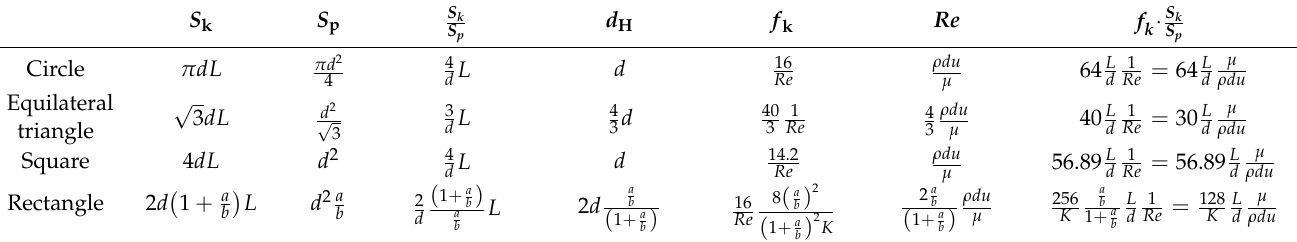
(cid:16) (cid:17) · S k · d = 128 According to Figure 4, since f k · ρ du monotonously decreases with respect L K S p µ to a , this also contributes to the monotonical decrease in ∆ p . Focusing on each of the divided b · d parameters, S k decreases monotonically in the same way, whereas f k · ρ du is found to L S p µ · S k · d have a local minimum value of ca. 11.4 when a is ca. 3.40. That is, f k · ρ du decreases L S p µ b monotonically and mitigates moderately when a takes more than ca. 3.40. Therefore, as a b condition for ensuring a low pressure drop, ∆ p , it is theoretically recommended that the aspect ratio, a , takes ca. 3.40 at least. The upper limit of a should be determined from the b b request of structural strength and/or flow uniformity, which especially affects reaction performance when scaling